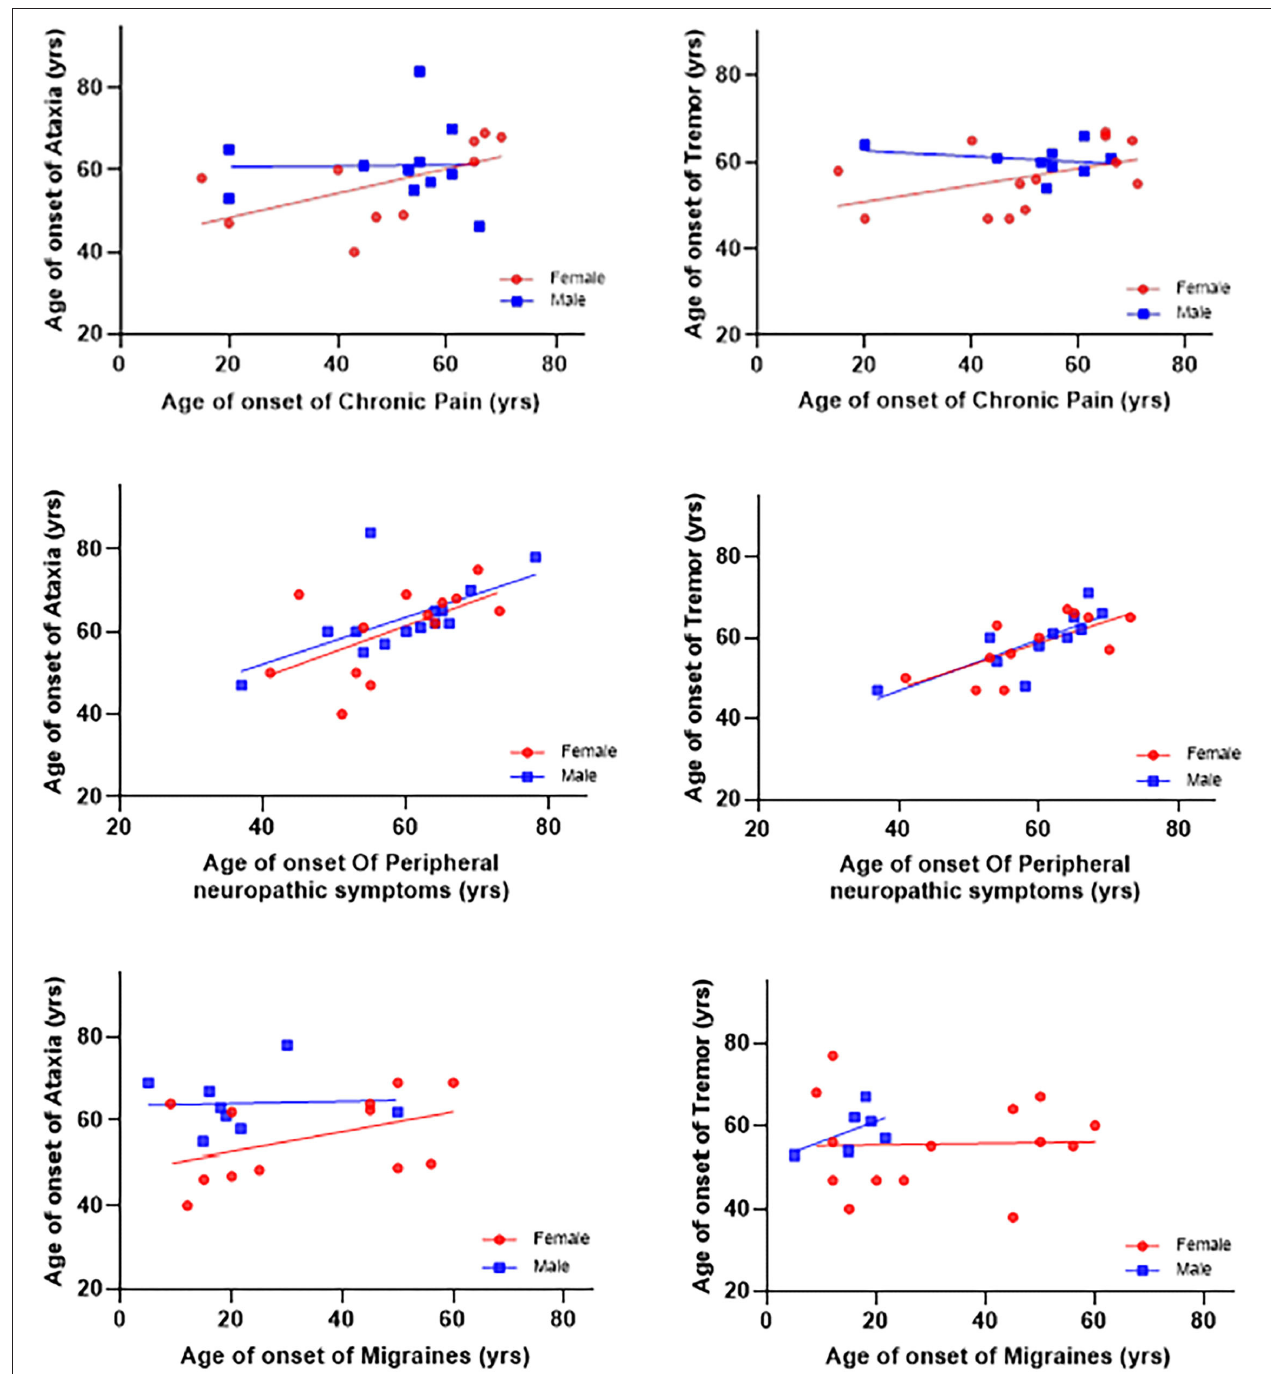
FIGURE 1 | Associations between ages of onset of symptoms and ataxia and tremor. The age of onset of peripheral neuropathy symptoms was positively associated with age of onset ataxia ( β = 0.56 ± 0.17, p = 0.004) and tremor ( β = 0.56 ± 0.17, p = 0.004). There were no significant associations between the onset of chronic pain and migraines with the onset of ataxia and tremor.